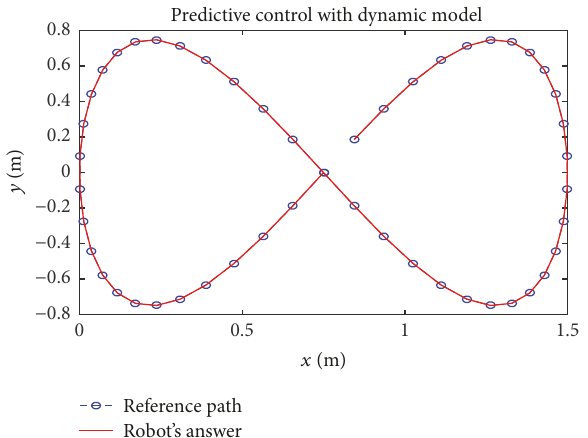
Figure 5: Lemniscate path following with the predictive control joined with the dynamic model.